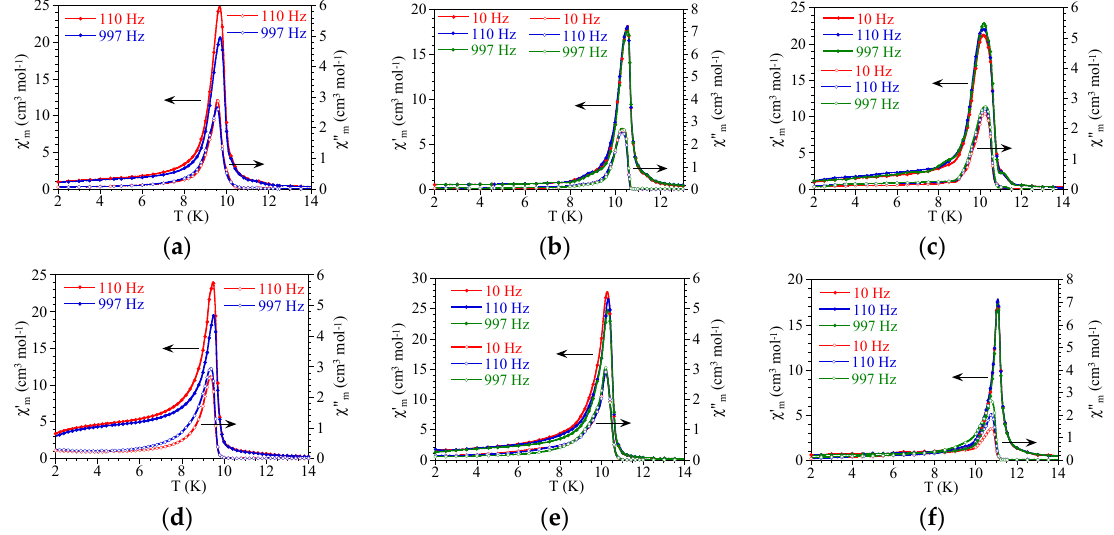
Figure 8. Thermal variation of the in-phase ( χ ’ m , left scales, filled symbols) and the out-of-phase ( χ ” m , right scales, empty symbols) of compounds 1 ( a ), 2 ( b ), 3 ( c ), 4 ( d ), 5 ( e ), and 6 ( f ) at different frequencies.